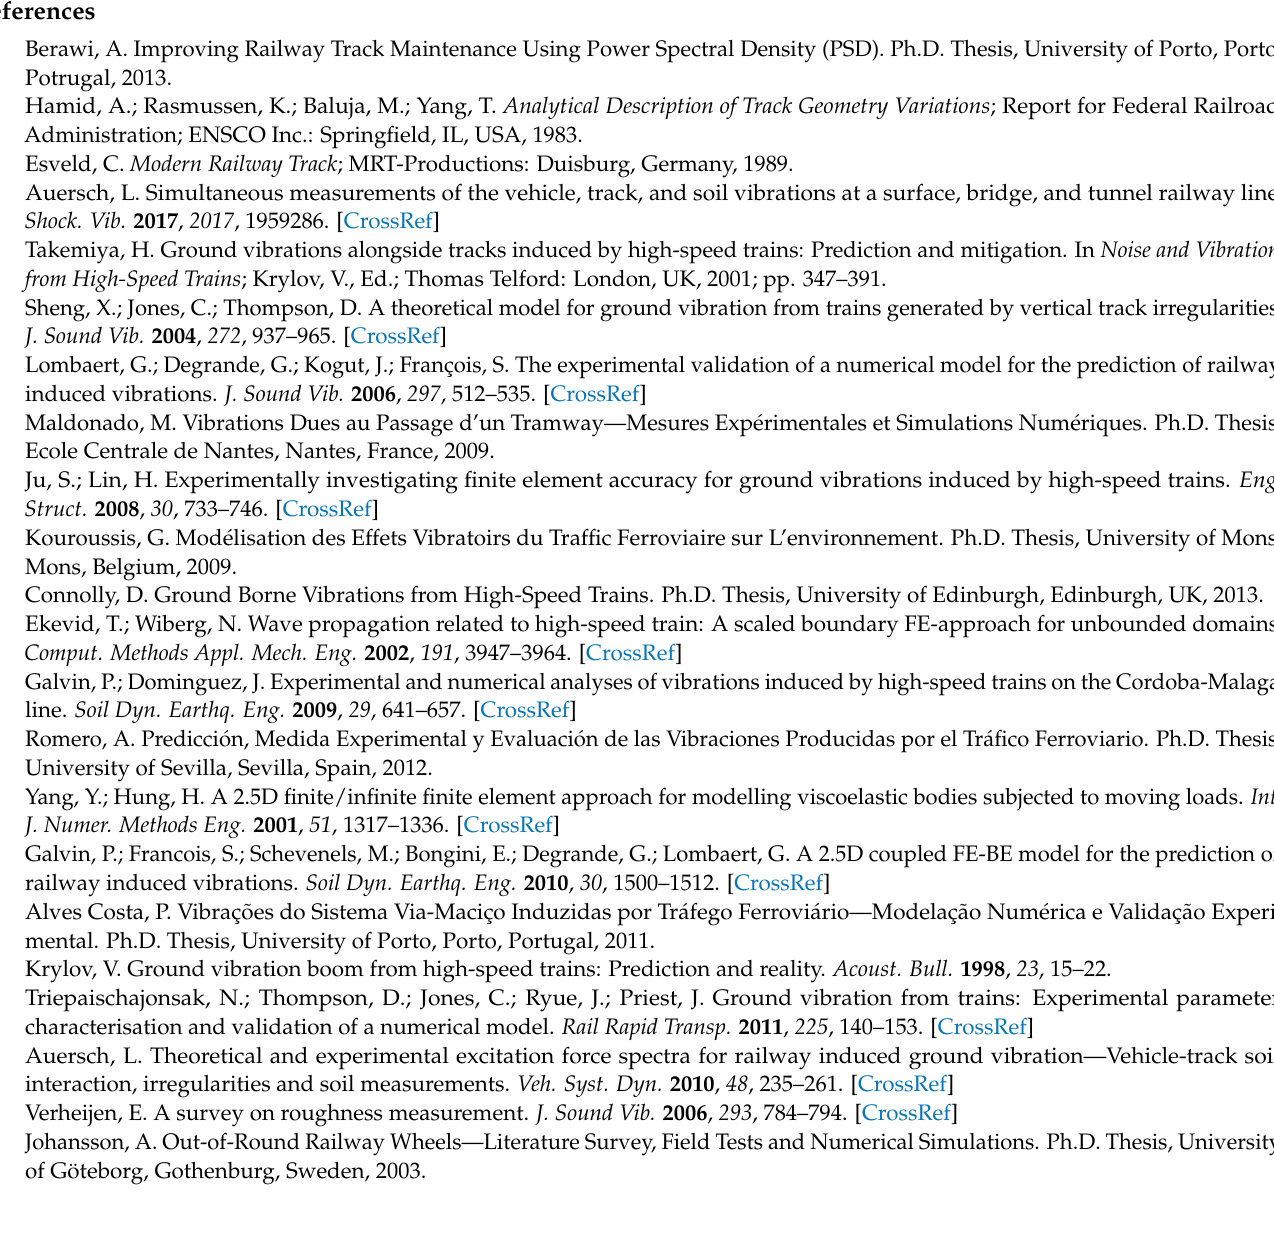
( a ) ( b ) ( c ) Figure A2. Dynamic stiffness of standard ballast track on soils with v S = □ 100, ○ 150, ∆ 200, + 300 m/s, ( a ) wavenumber domain method with continuous soil, ( b ) with approximated Winkler soil, ( c ) boundary-element/finite-element method.